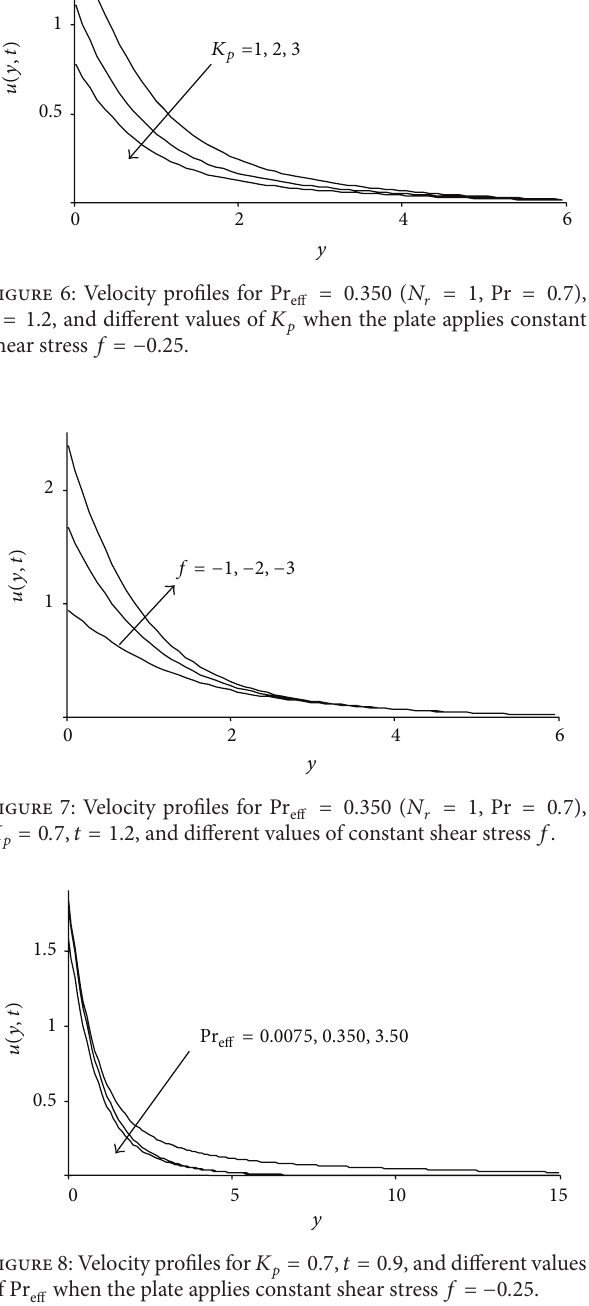
Figure 8: Velocity profiles for 𝐾 𝑝 = 0 . 7, 𝑡 = 0 . 9, and different values of Pr eff when the plate applies constant shear stress 𝑓 = − 0 . 25.